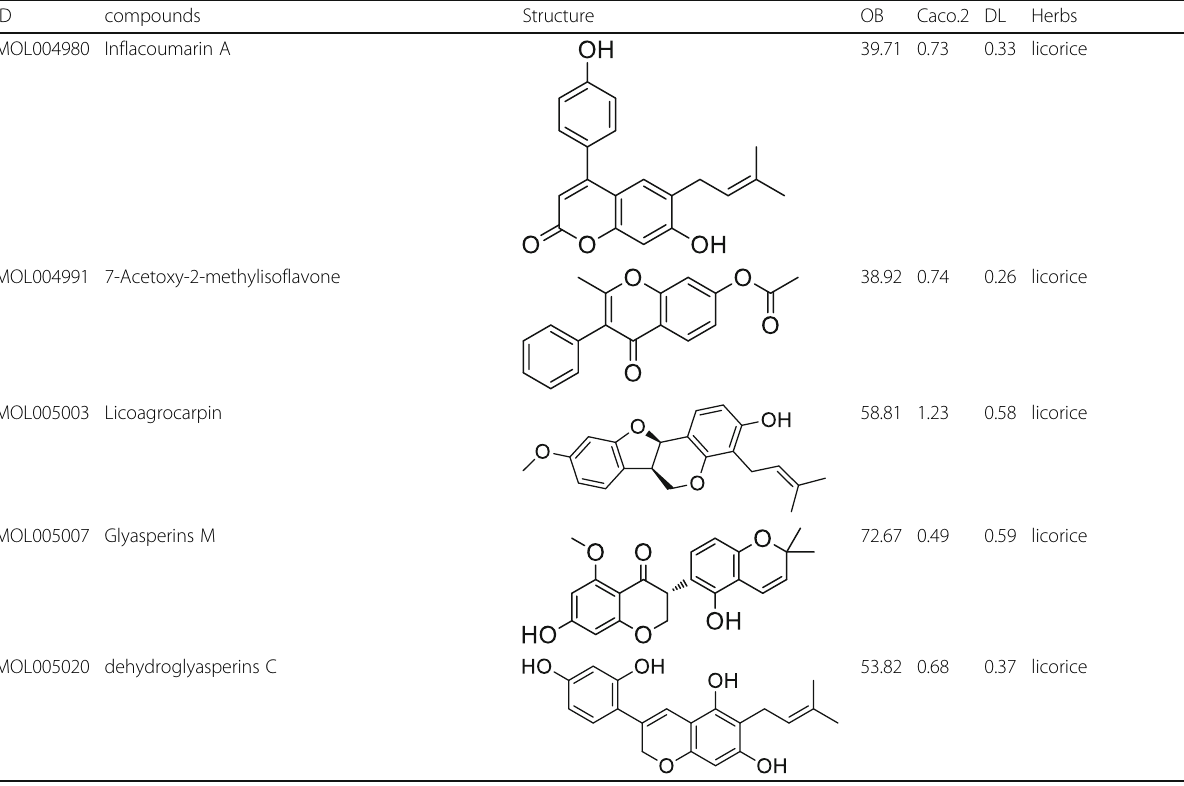
Table 1 Information of active compound by ADME filtering (Continued)